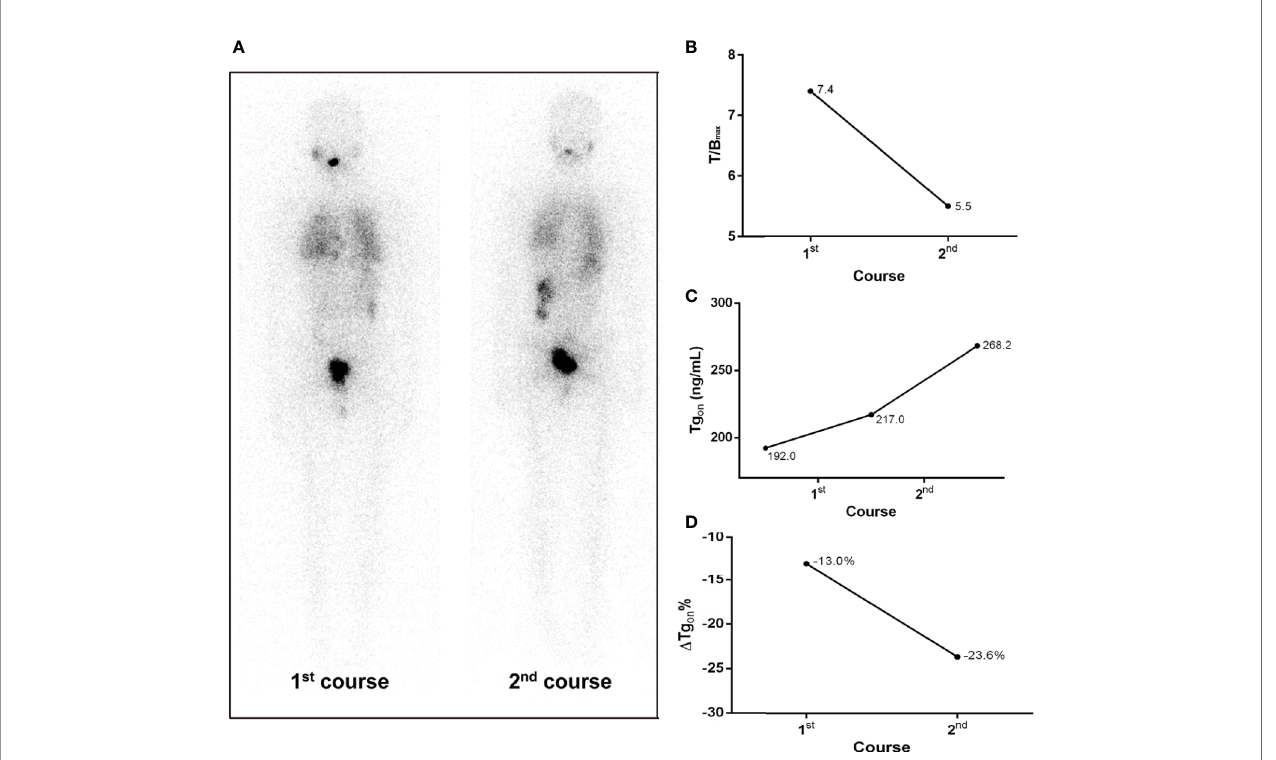
FIGURE 3 | A 20-year-old female differentiated thyroid cancer patient with 131 I-avid pulmonary metastases not responding to RT. The T/B max and D Tg on % resulting from the initial course of RT were less than 8.1 and 25.3%, respectively, indicating a non-effective RT was achievable in the paired latter courses, which was con fi rmed by the increase in Tg on (23.6%) at 4 months after the second course of RT. (A) Whole body scans (anterior) at 3 days after the oral administration of 7.4 GBq of 131 I; (B) T/B max ; (C) Tg on ; (D) D Tg on %. RT, radioiodine treatment; T/B max , maximum target-to-background ratio; Tg on , thyroid stimulating hormone- suppressed thyroglobulin; D Tg on %, change rate of Tg on